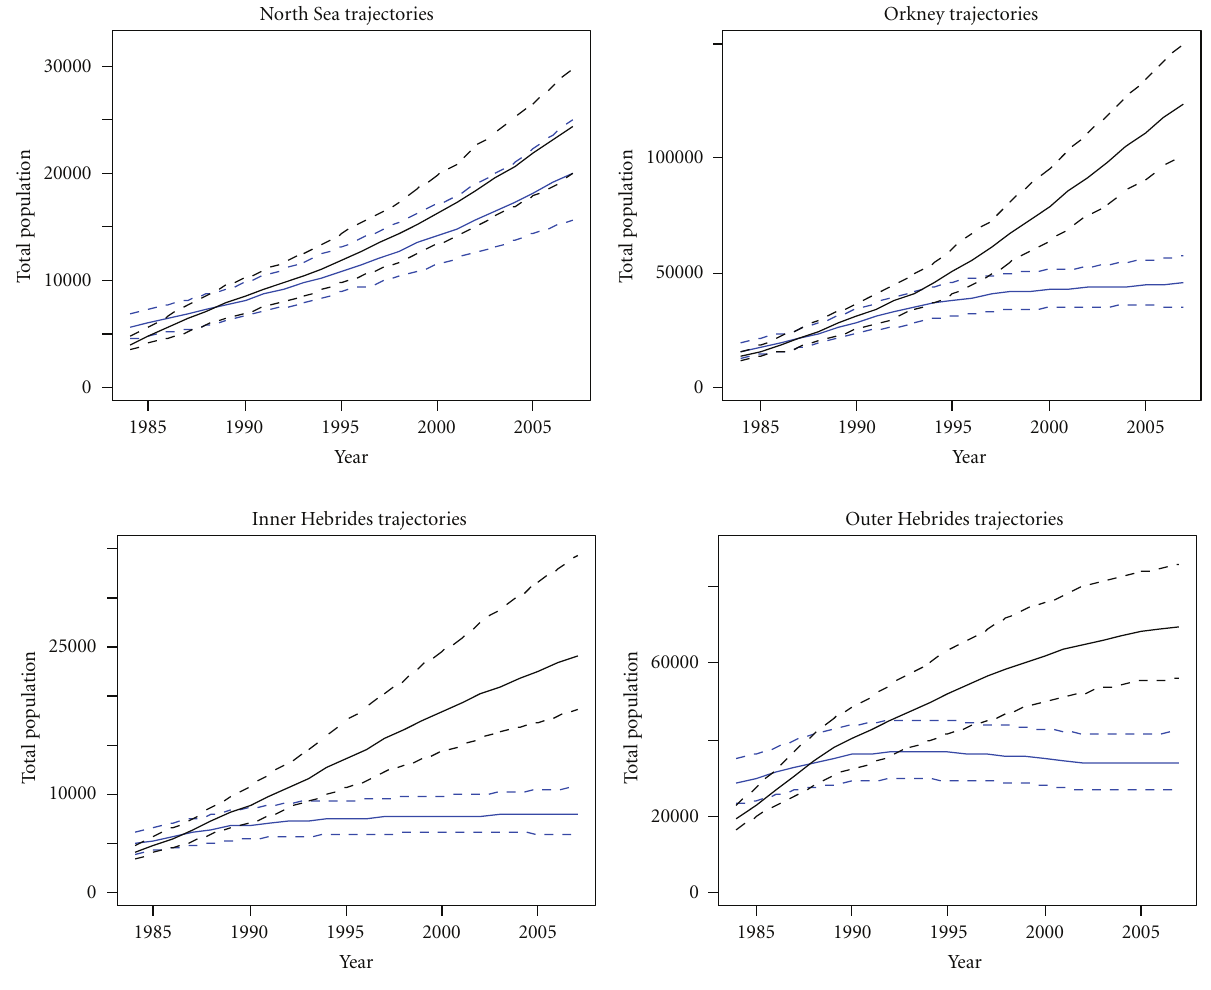
Figure 2: Population trajectories (mean values and 95% credibility intervals) for each region. In each case, the lower (blue) set of lines show the total population estimates from the density-dependent pup survival models and the upper (black) set of lines those from the models with density-dependent